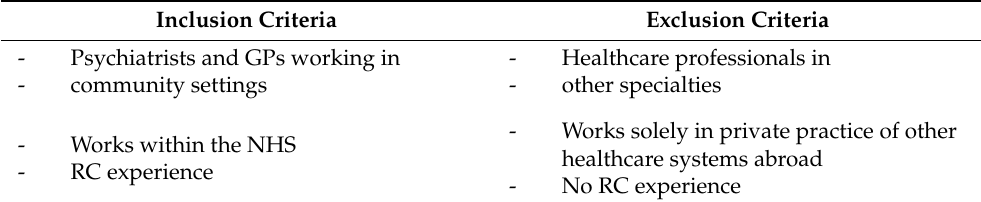
Table 1. Criteria for interview